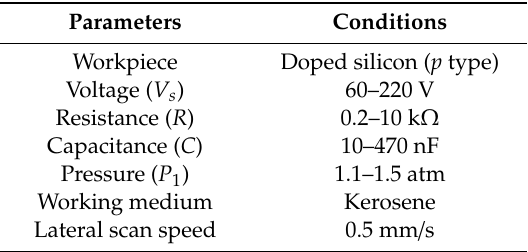
Table 2. Experimental conditions.